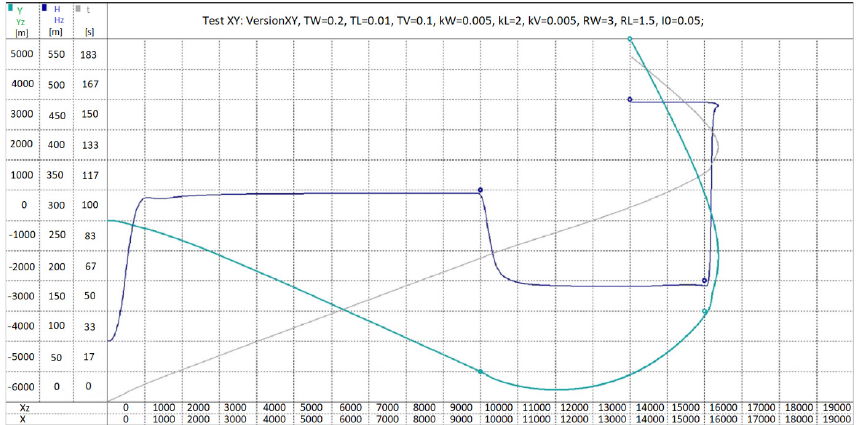
Figure 13. Complex flight manoeuvre to the coordinates of three points on plane Y z and the preset altitudes H z , (350, 200, 500 [m] ) for the coefficient of reinforcement k w = 0.005 and the derivative constant R w. = 3 [s]. UAV at the preset altitude reaches the particular points after approximately 80, 120, 190 [s],